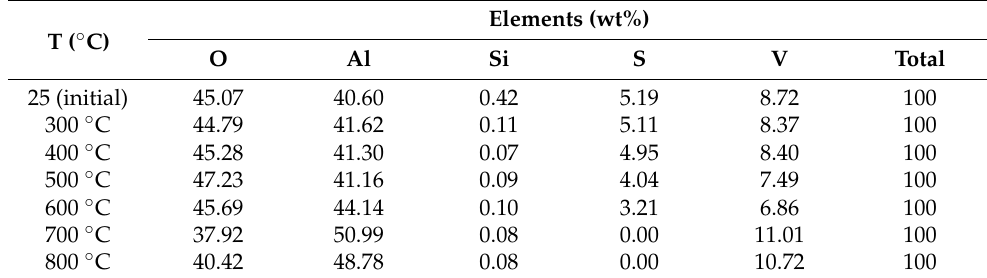
Table 1. Elemental content of the 10% V/ γ Al 2 O 3 catalyst calcined in air at different temperatures. T ( ◦